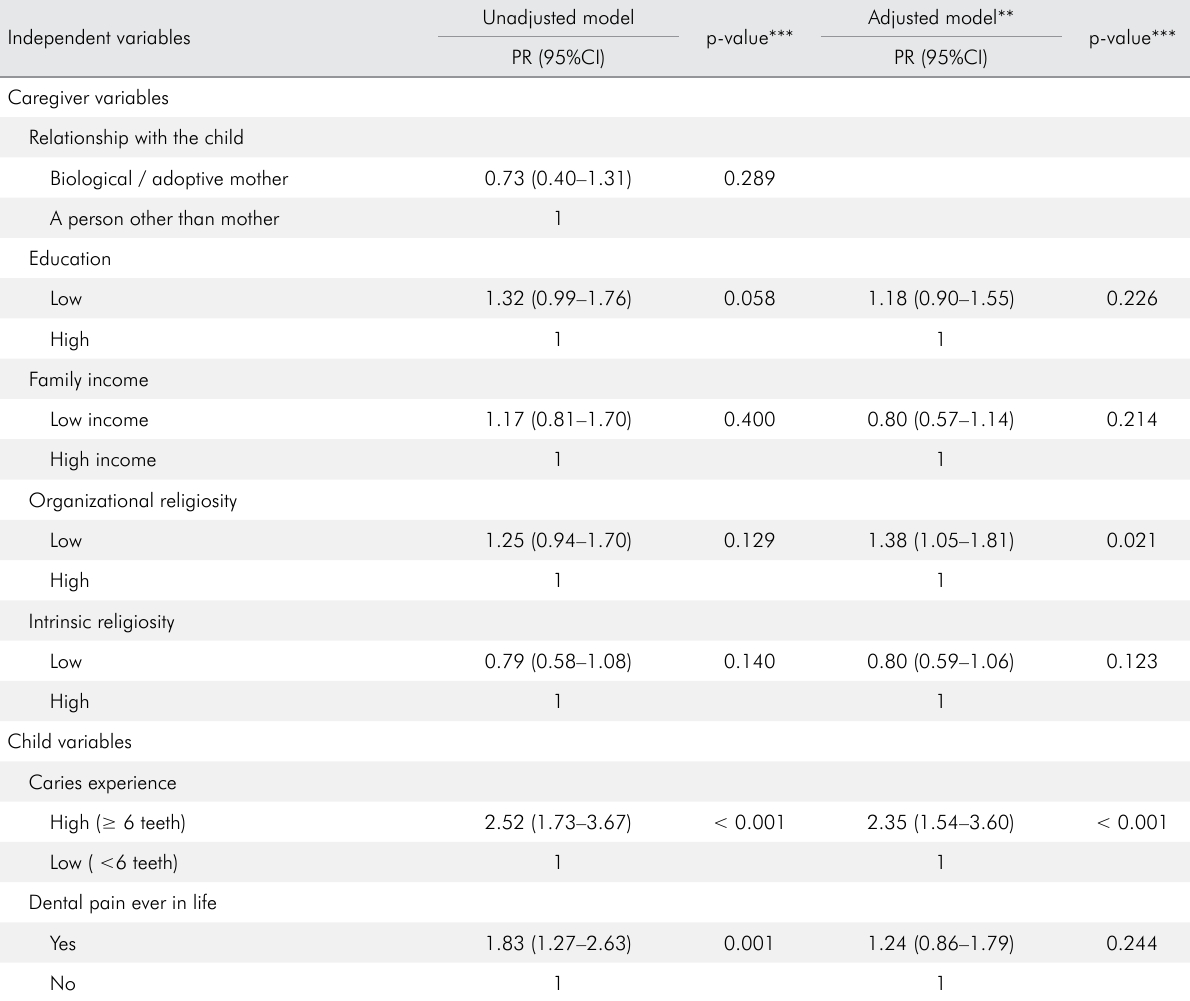
Table 3. Poisson regression analysis of the association between negative caregivers’ perception of children’s dental health and independent variables (n =